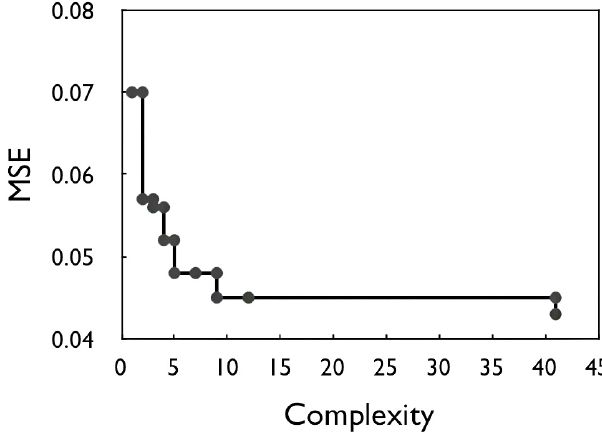
Figure 5. Reference concentration Pareto front; MSE is mean squared error of candidate solution versus the validation data set. Complexity is a quantification of the candidate solution length (both mathematical operators and